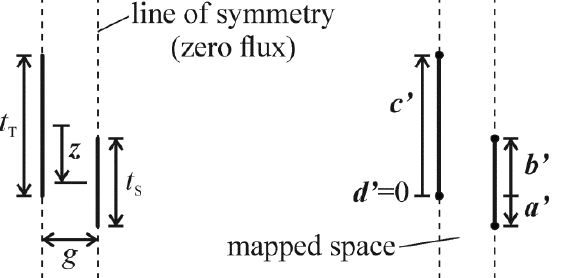
Figure 3. Two different representations of the two-dimensional model of the space between opposing teeth of negligible